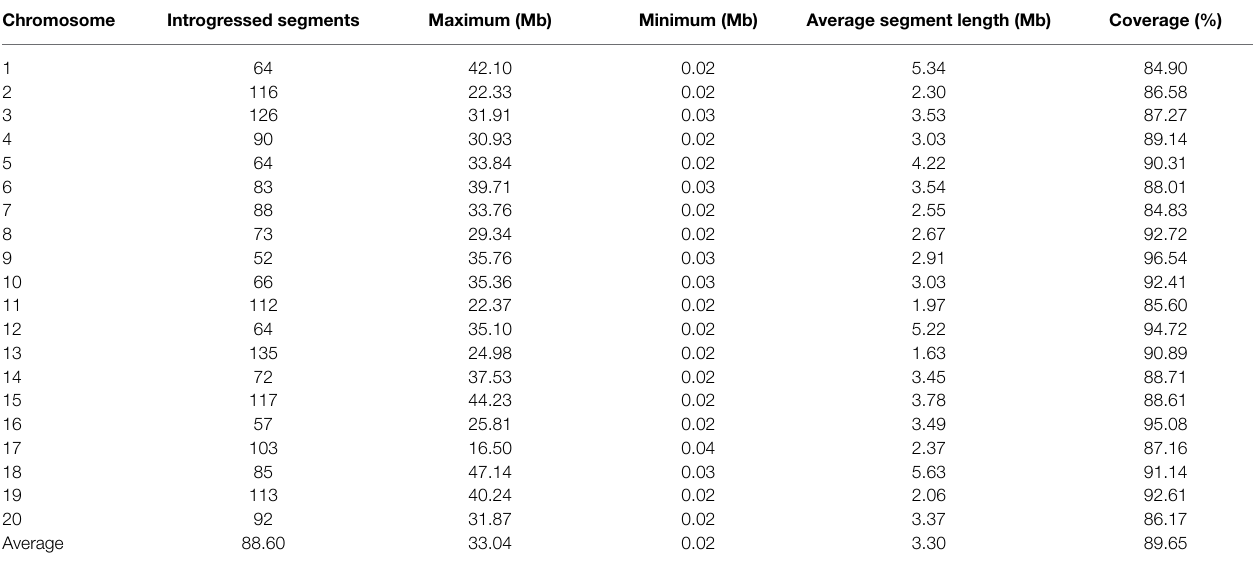
TABLE 4 | The number and coverage of introgressed fragments per chromosome in CSSLs.